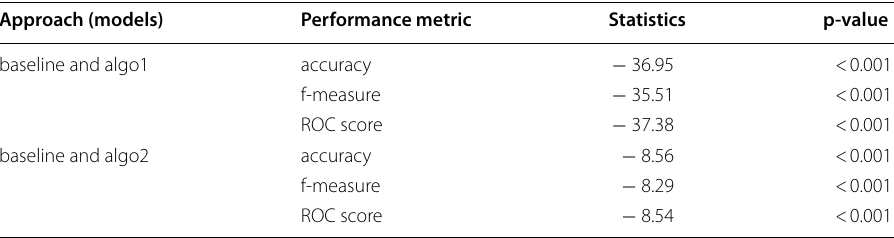
f-measure ROC score